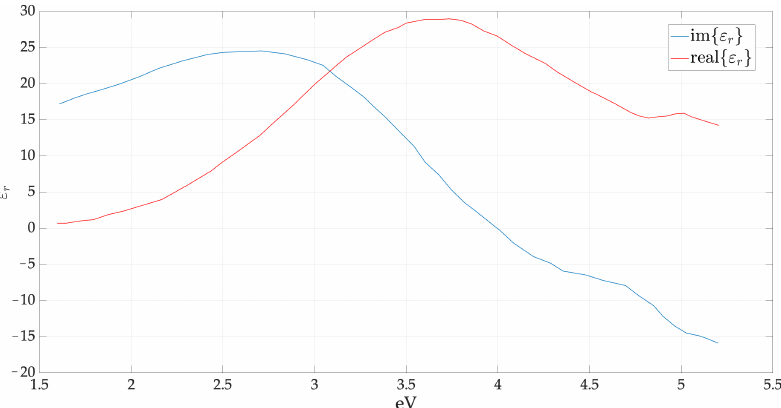
Figure 3. The real and imaginary part of amorphous silicon and doped relative dielectric constant as a function of photon